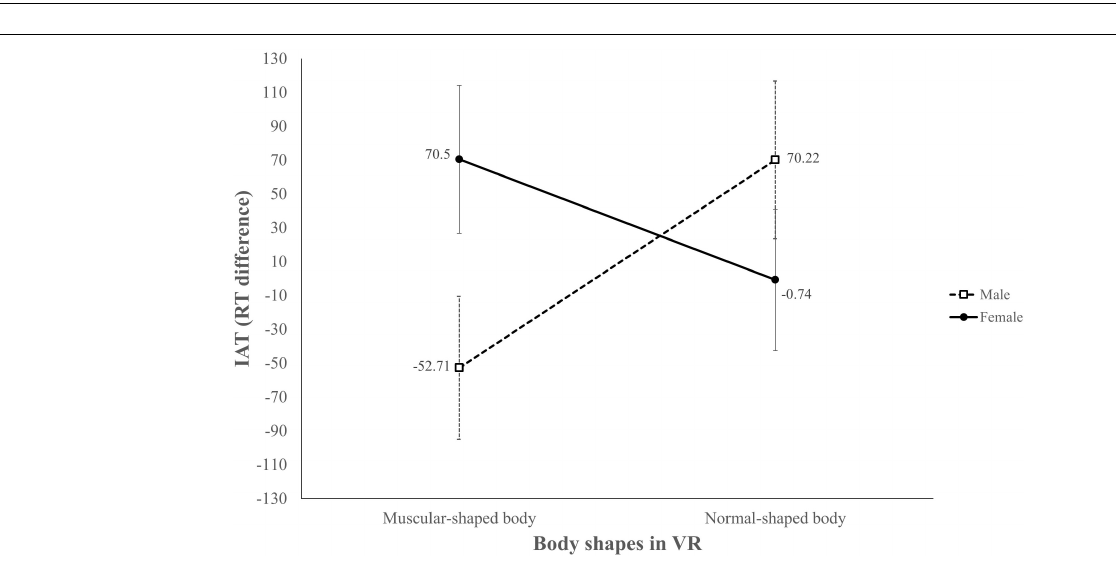
FIGURE 6 | Adjusted mean score of next-day self-efficacy for core workouts.